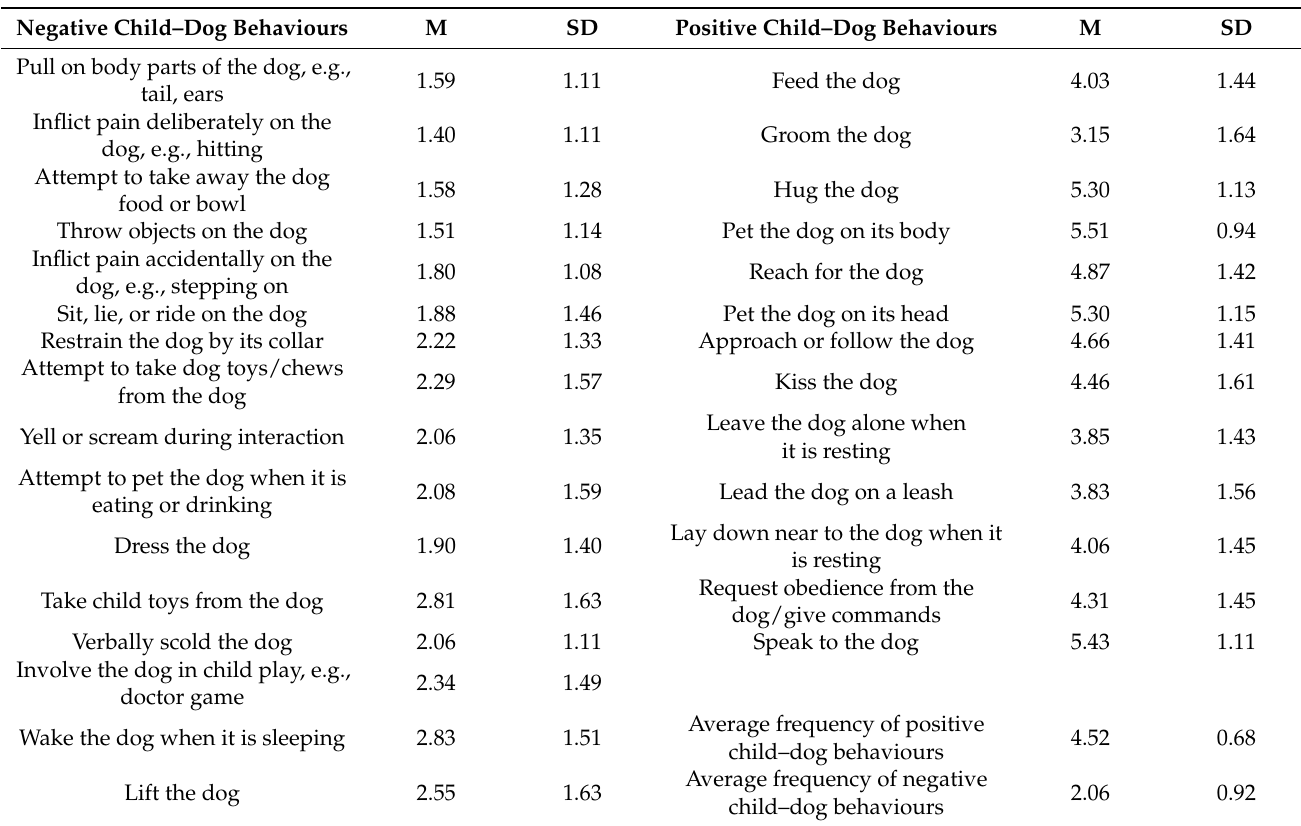
Table 4. Descriptive statistics for caregiver-reported positive and negative child–dog behaviours. Minimum 1, maximum